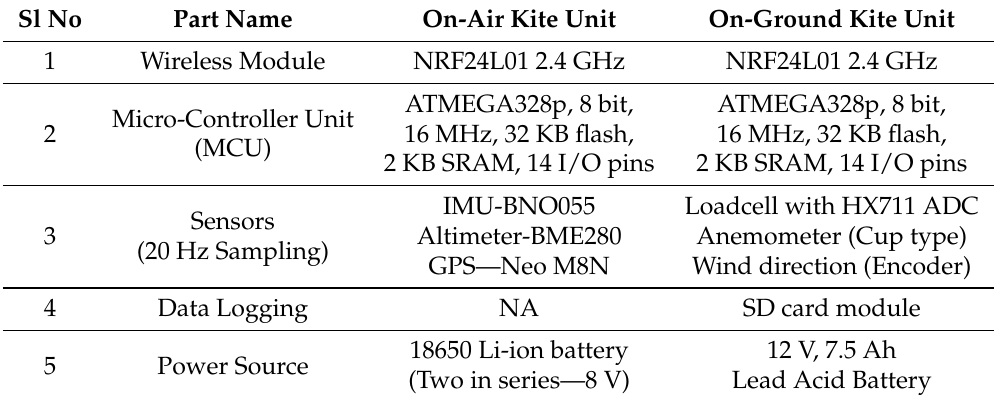
Table 2. Kite telemetry system: on-air kite unit specifications and on-ground kite unit